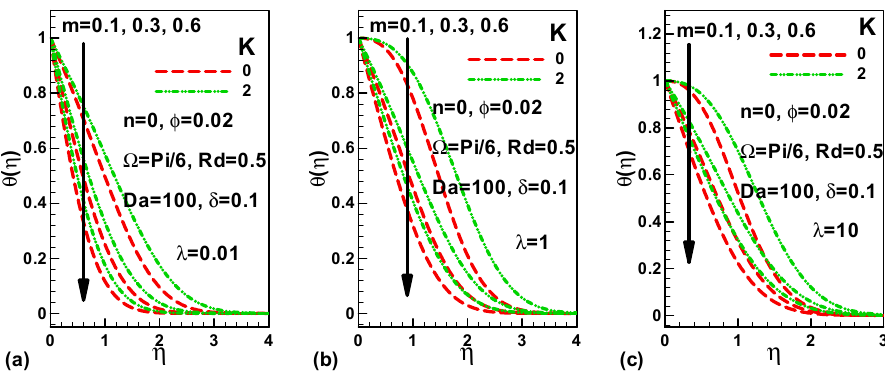
Figure 4. Variation of dimensionless temperature with pressure gradient parameter for ( a ) forced convection, ( b ) mixed convection, and ( c ) free convection.